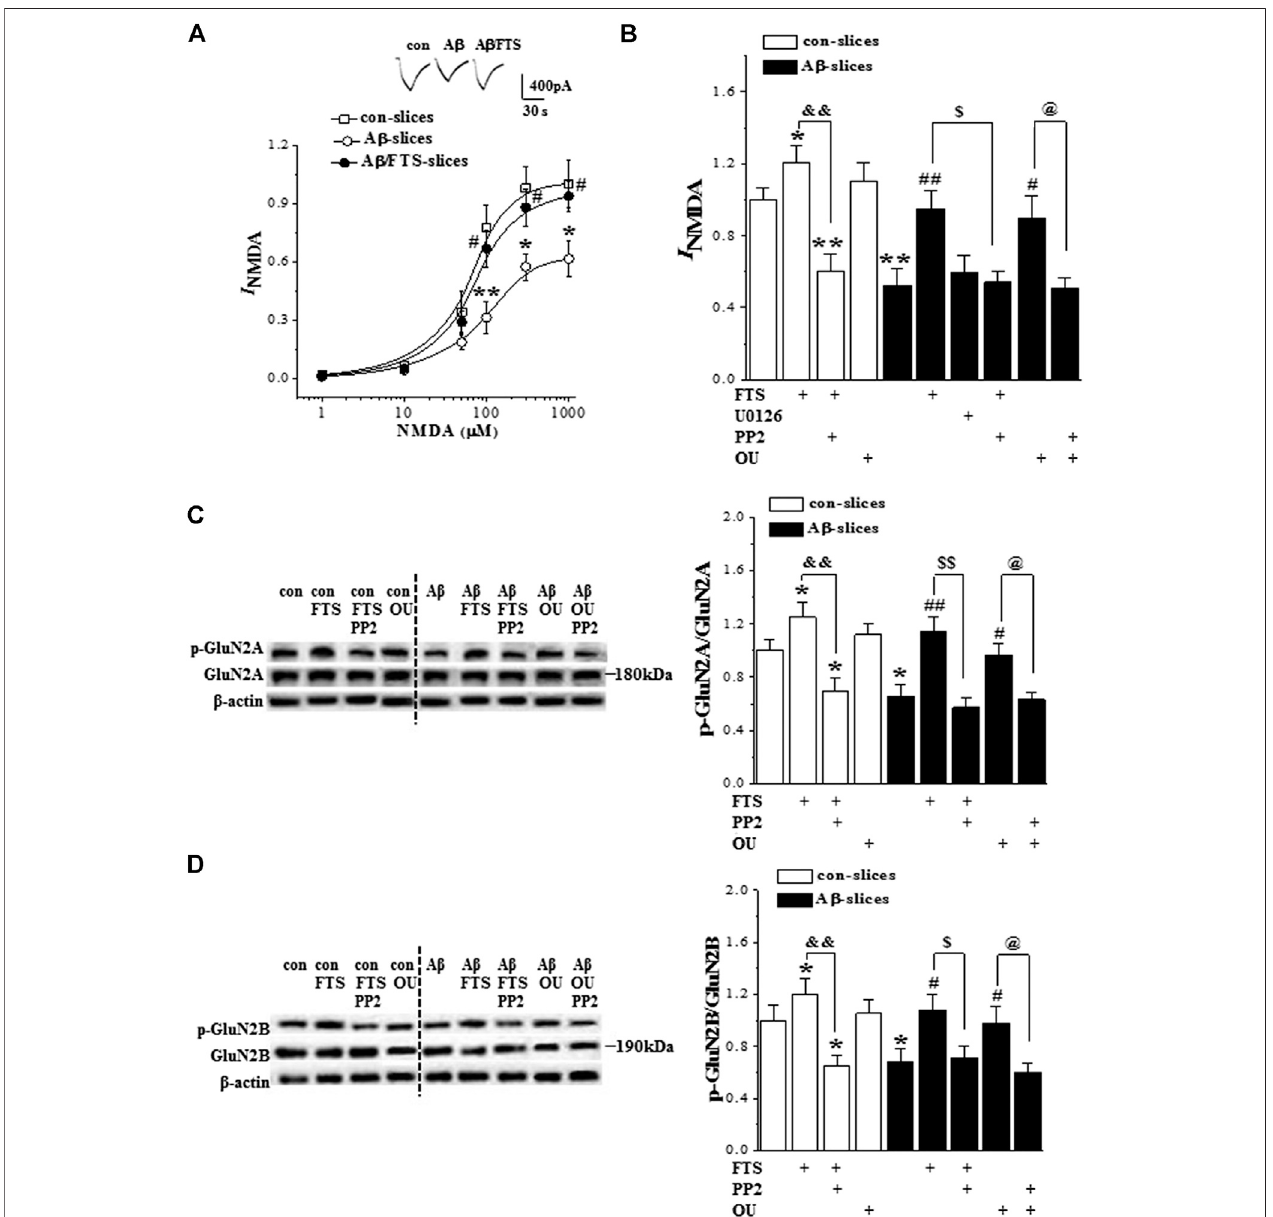
FIGURE 6 | A β 1-42 -activated Ras reduces NMDAR function via down-regulation of Src. (A) Evoked I NMDA by NMDA (1 – 1,000 μ M) in in control slices (con), A β 1-42 - slices(A β )andA β 1-42 /FTS-slices(A β /FTS).Each pointrepresentsthedensitiesof I NMDA normalizedbycontrolvalueevokedbyNMDA(1,000 μ M).Representativetraces of I NMDA evokedby100 μ MNMDA.* p < 0.05and** p < 0.01vs.controlslices;# p < 0.05vs.A β 1-42 -slices(repeated-measureANOVA,n (cid:1) 6pergroup). (B) Barsshowthe